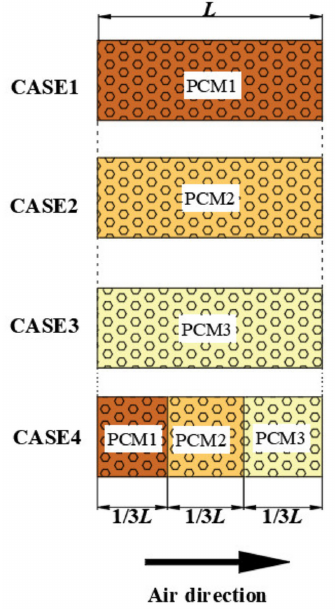
Figure 5. Schematic diagram of different arrangements of